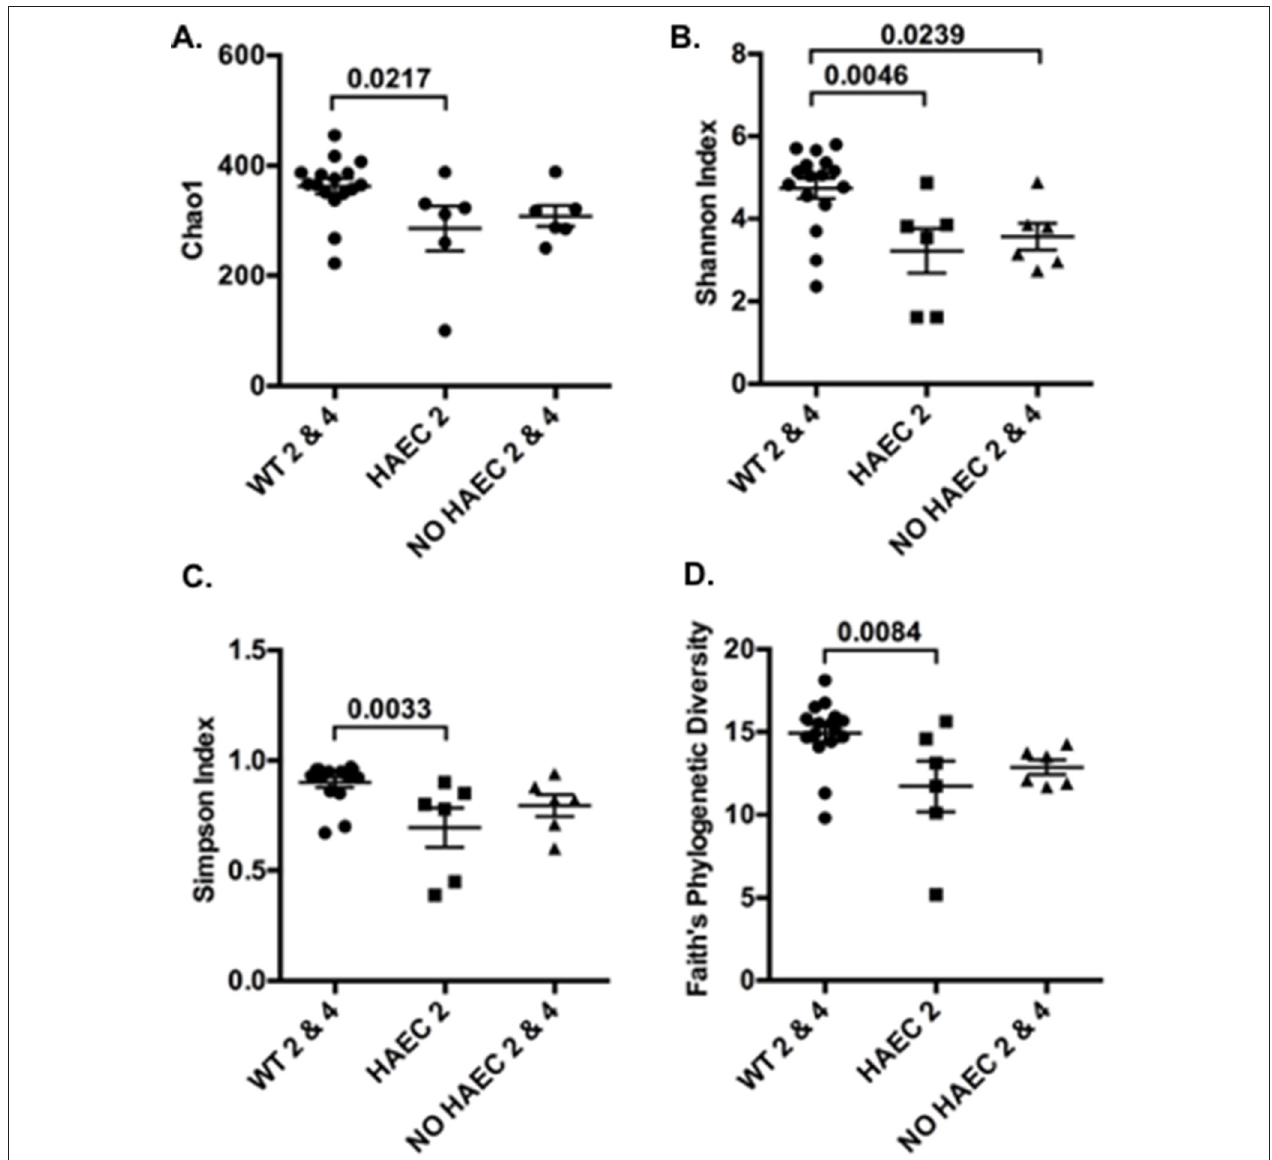
Figure 3 | Alpha diversity of fecal bacteria measured at several times in relation to pull-through surgery from WT and Ednrb −/− mice with and without HAEC. Four different metrics were used: (a) Chao1, (B) Shannon Index, (c) Simpson Index and (D) Faith’s Phylogenetic Diversity. P-values from ANOVAs are indicated above brackets. Bars are SE. n = 8 (WT 0, 2, 4), 6 (HAEC 0, 2), 4 (NO HAEC 0, 2), 2 (NO HAEC